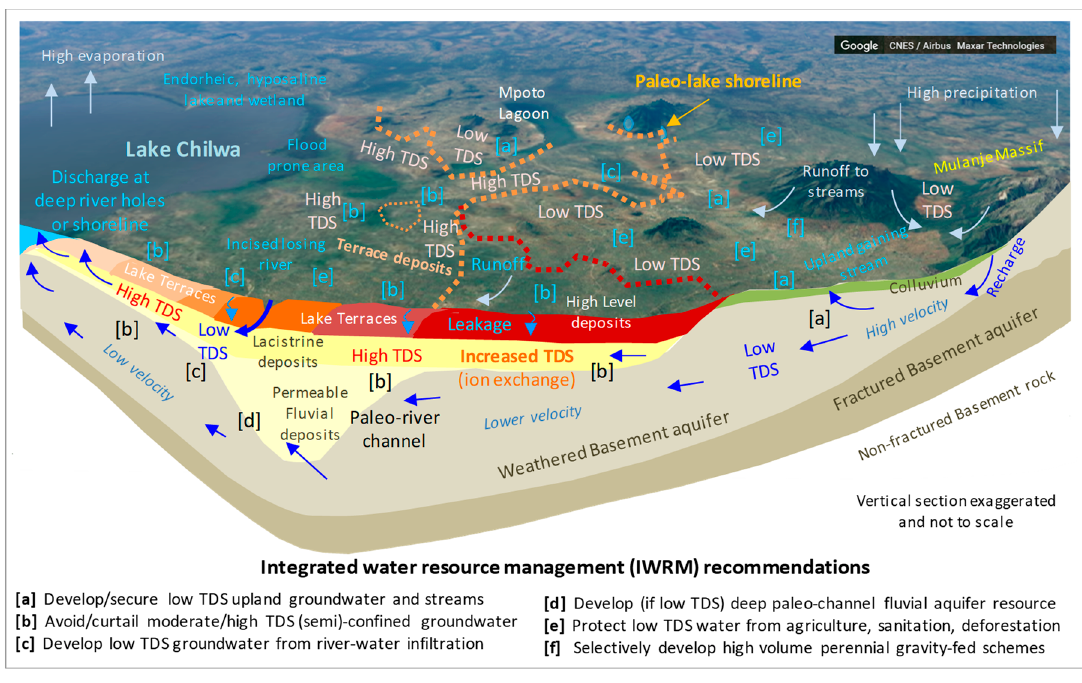
Figure 15. Conceptual model of the Lake Chilwa Basin–Phalombe District groundwater system illustrating the geohydrological control of the paleo-lake environments and recommendations for Integrated Water Resource Management shown with labelled locations [a] to [f] of example application (approximate line of section is shown in Figure 2). Flow regime and water quality control detail inherent to the conceptualisation are summarized in the text bullet points.